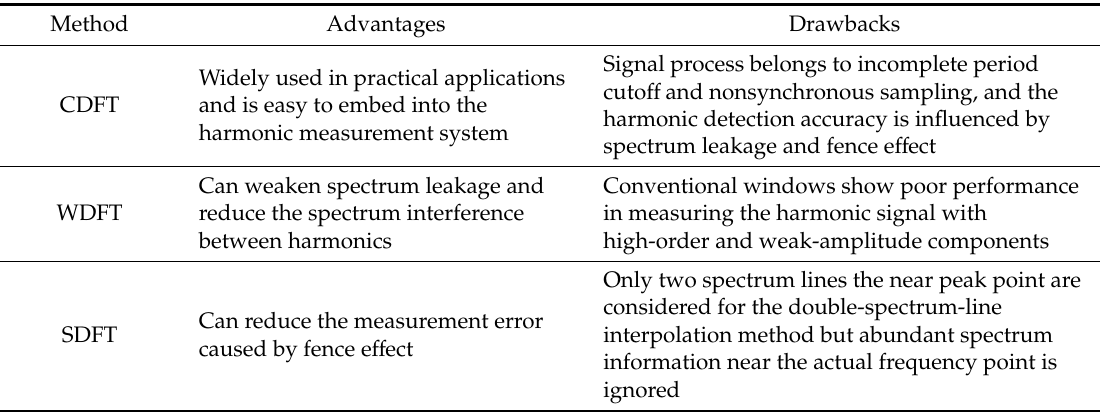
Table 1. Synopsis of harmonic detection methods. CDFT—conventional discrete Fourier transform harmonic detection method; WDFT—windowed discrete Fourier transform harmonic detection method; and SDFT—spectrum-line interpolation discrete Fourier transform harmonic detection